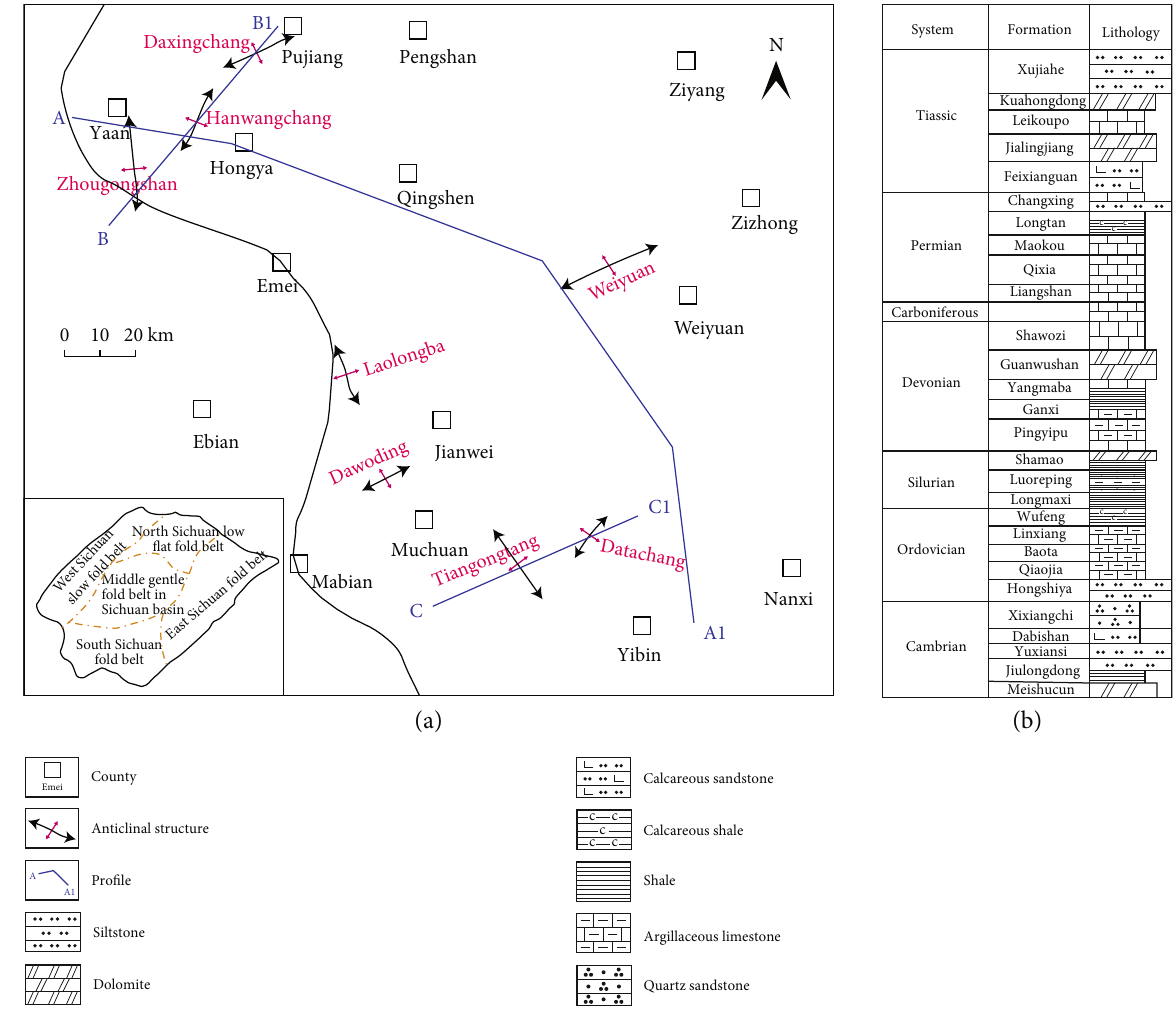
Figure 1: Geological overview of the study area. (a) Tectonic location. (b) Stratigraphic